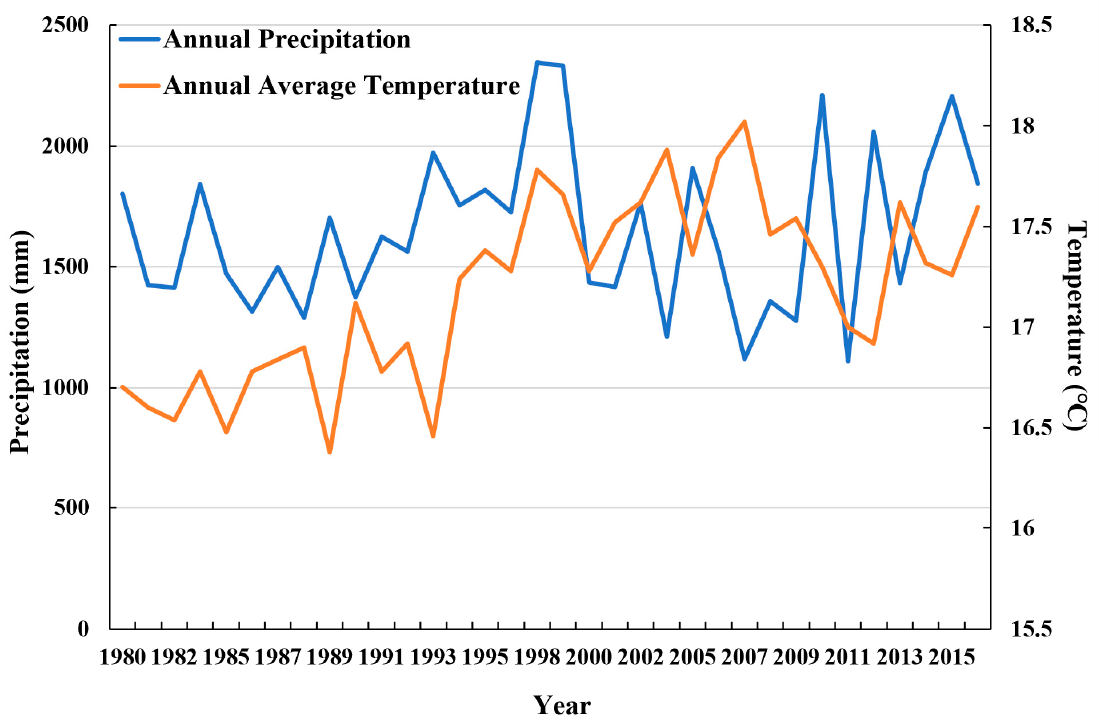
Figure 2. Average annual precipitation and average temperature changes in the MYRB.